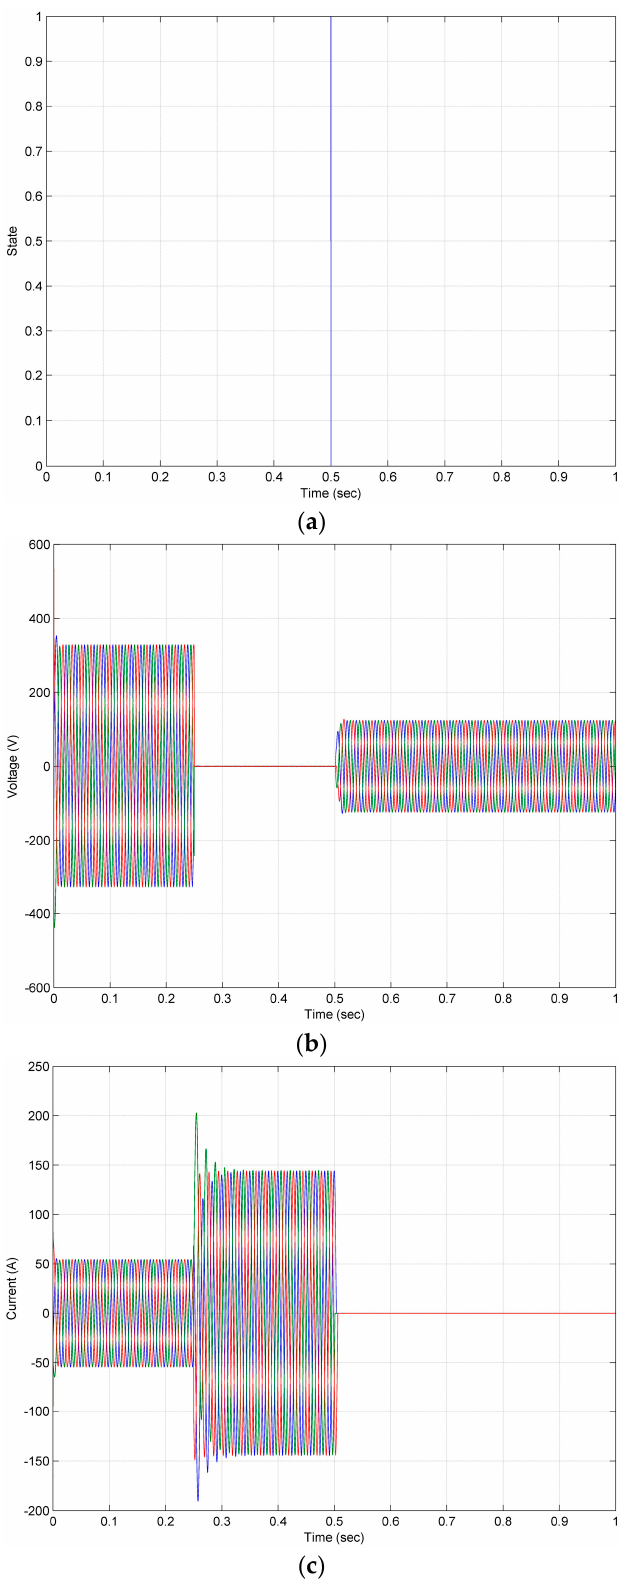
Figure 16. ( a ) CB14 CLOSE/TRIP state; ( b ) Feeder voltage waveforms of CB14 under islanded mode and fault occurrence at Bus 2; ( c ) Feeder current waveforms of CB14 under islanded mode and fault occurrence at Bus 2.